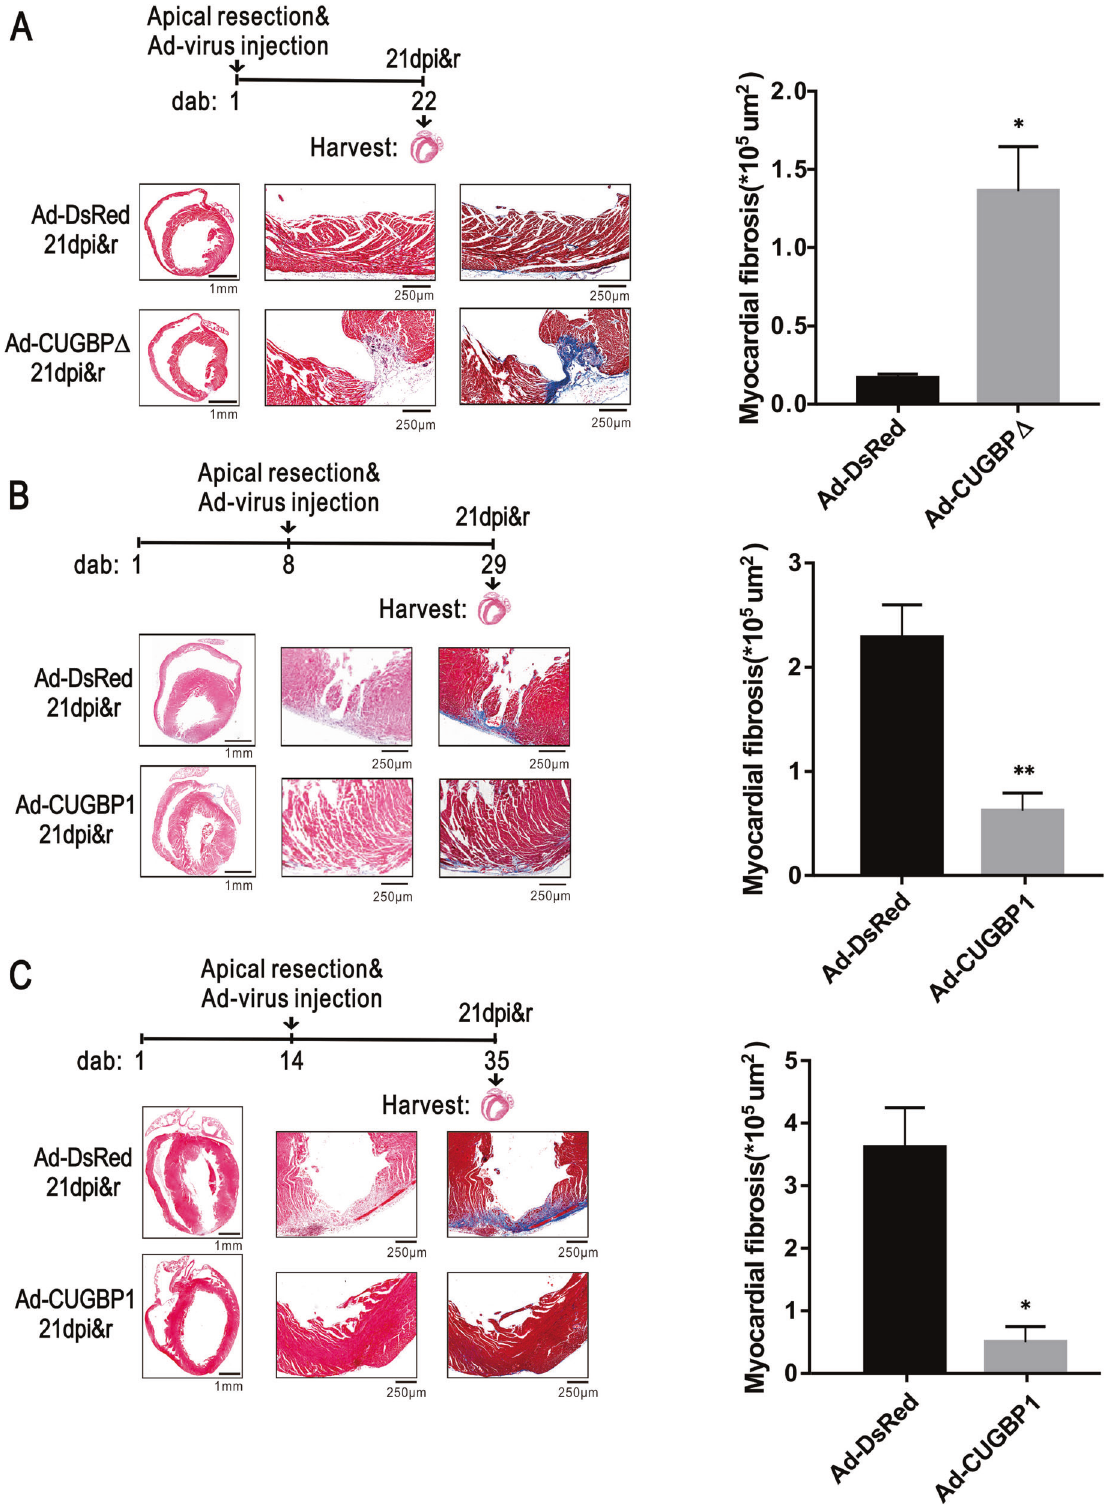
Fig. 2 CUGBP1 reconstitution markedly promoted heart regeneration. One-day ( A ), 8-day ( B ), or 14-day ( C ) old mice were administrated with Ad-virus and apical resection was performed simultaneously. The HE staining of the whole heart and HE, Masson trichromatic staining of the apex of the heart at high magni fi cation were presented ( n = 3 – 4). dab, days after birth; dpi&r, days post injection & resection. Statistical analysis of the myocardial fi brosis are presented in the right panel.